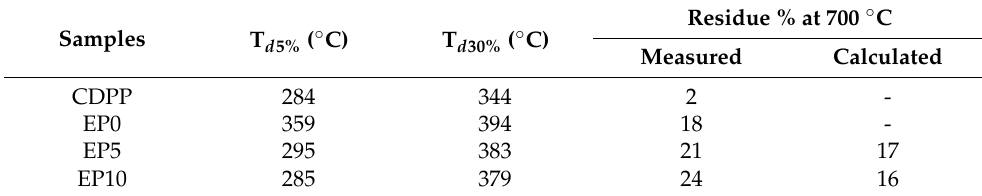
Table 2. Thermogravimetric data of CDPP and EP